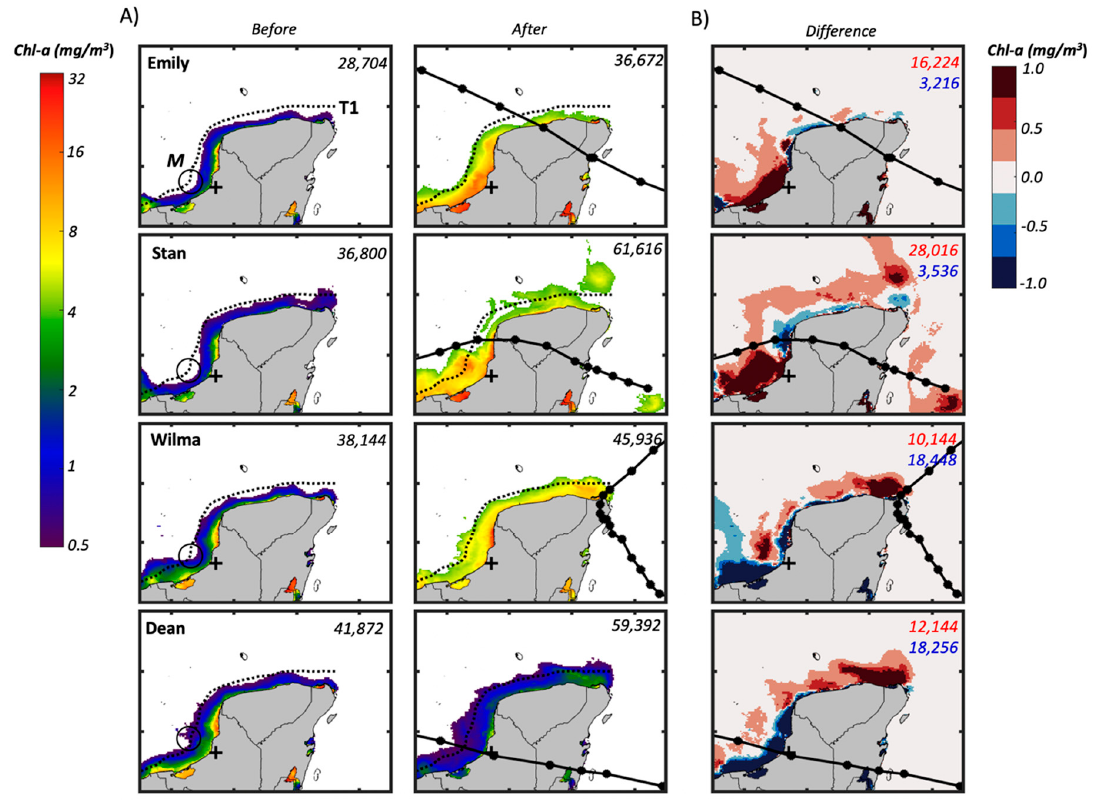
Figure 10. ( A ) Chl-a (mg/m 3 ; averaged seven days before and after landfall) in the Caribbean Sea, Gulf of Mexico, and coastal regions of the Yucatan Peninsula. The area (km 2 ) covered by pixels with a concentration above 0.5 mg/m 3 is shown on the panel right corner before and after landfall; the dotted line off the peninsula on the left panel is the transect (T1) discussed in the text (see Figure 11). Tropical cyclone tracks (lines and dots) are at 6-h intervals; concentrations are seven days before (left column) and after (right column) landfall. ( B ) Net Chl -a differences (i.e., before minus after storm passage) for areas (km 2 ) above (red tones) and below (blue tones) 0.5 mg/m 3 concentrations. The plus sign indicates the location of the Champoton River gauge.